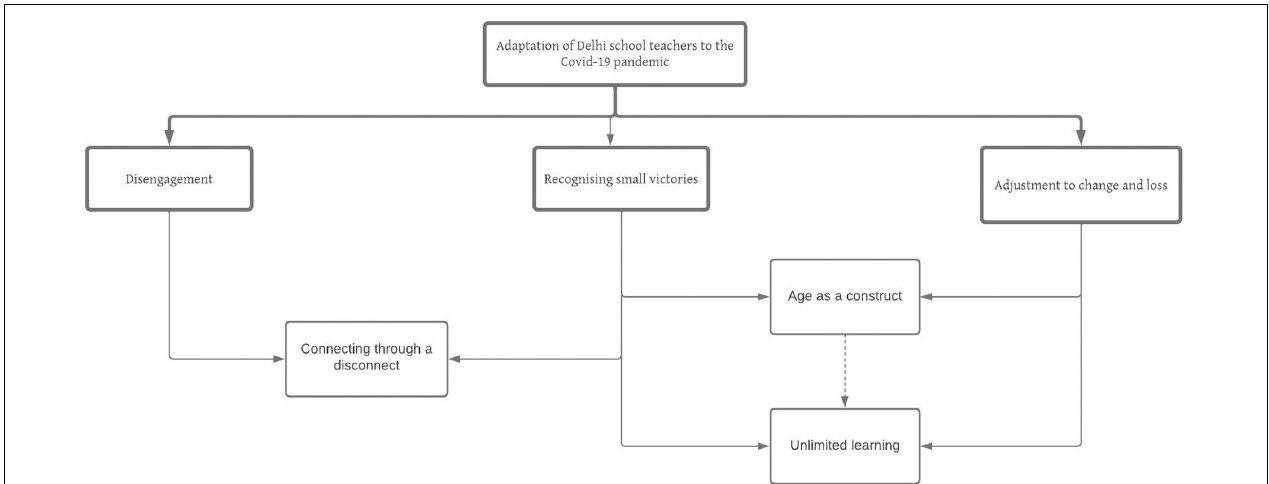
FIGURE 1 | Themes from the